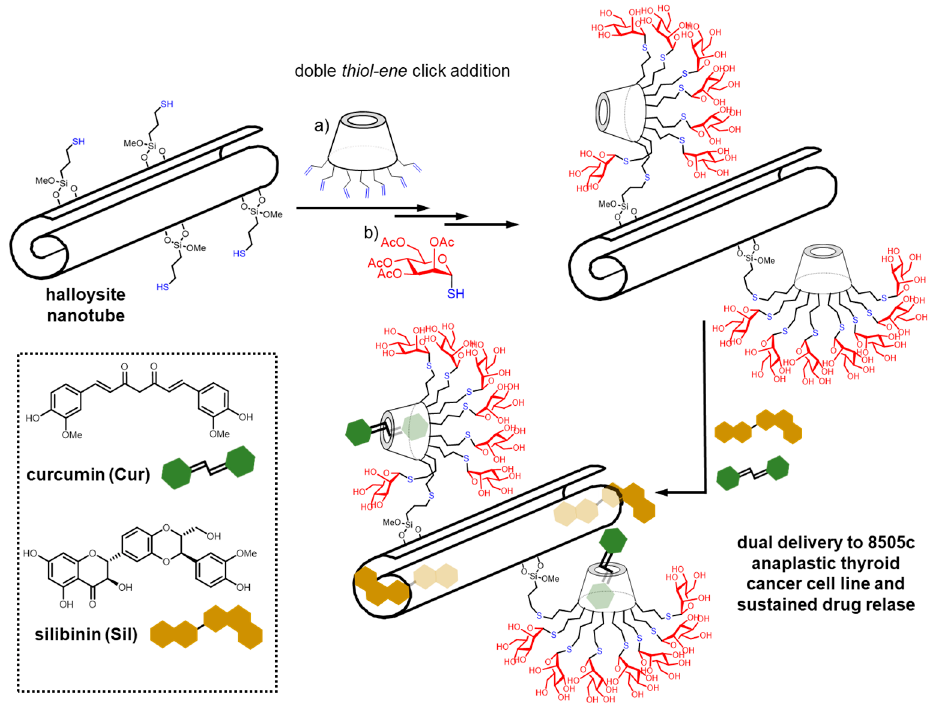
Figure 23. Structures and schematic representation of the strategy developed by Riela, Lazzala and coworkers to assemble hybrid glycoCD/halloysite nanotubes to achieve functional glyconanomaterials for the co-administration of curcumin (Cur) and silibinin (Sil) in thyroid cancer cells [196,197].